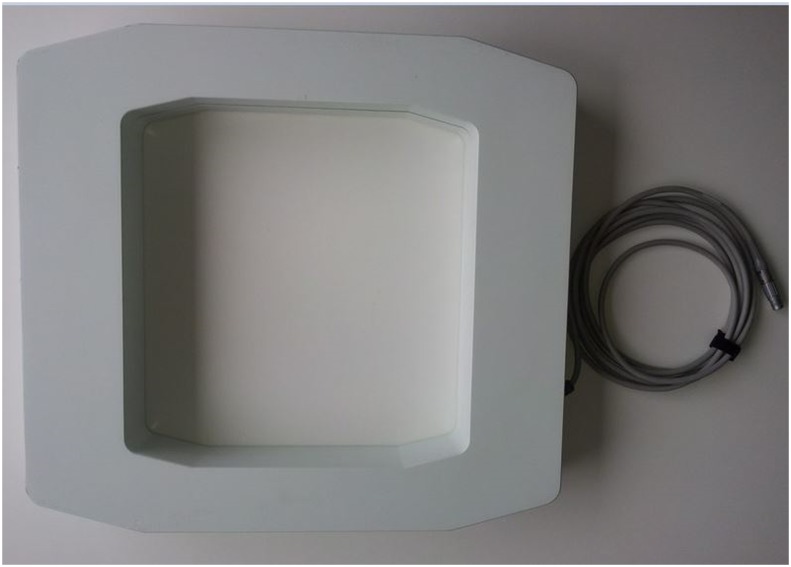
EM-Field Generator.